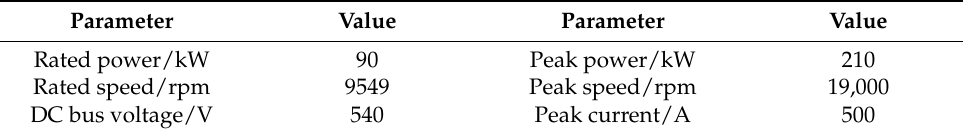
Figure 8. Model diagram of permanent magnet motor. Table 1. Some performance parameters of permanent magnet motor.